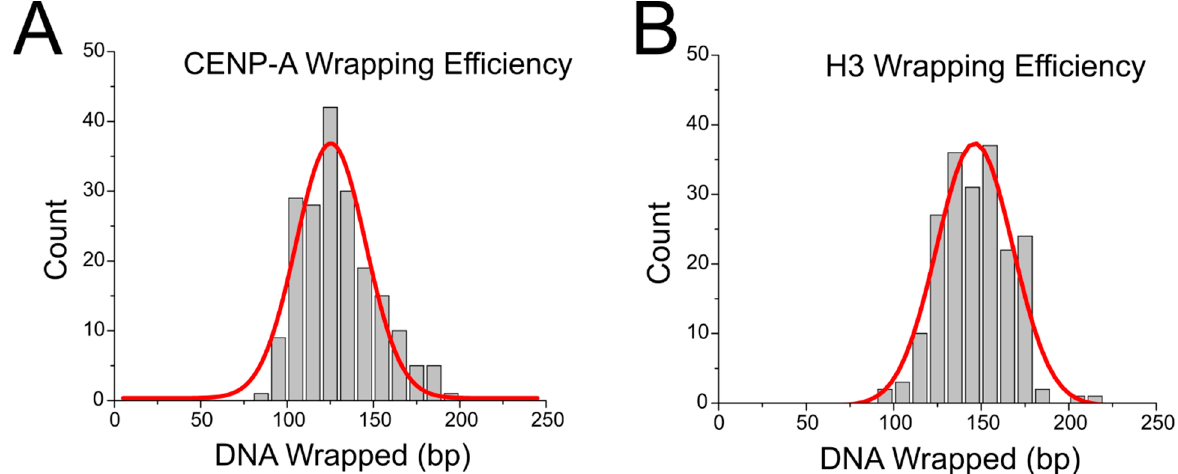
Figure 3. Histograms with Gaussian fitting of CENP-A nucleosome ( A ) and H3 nucleosome ( B ) wrapping efficiency on the α -satellite DNA substrate reveal a mean wrapping efficiency of 125 ± 20 bp and 146 ± 22 bp for CENP-A and H3 nucleosomes, respectively.